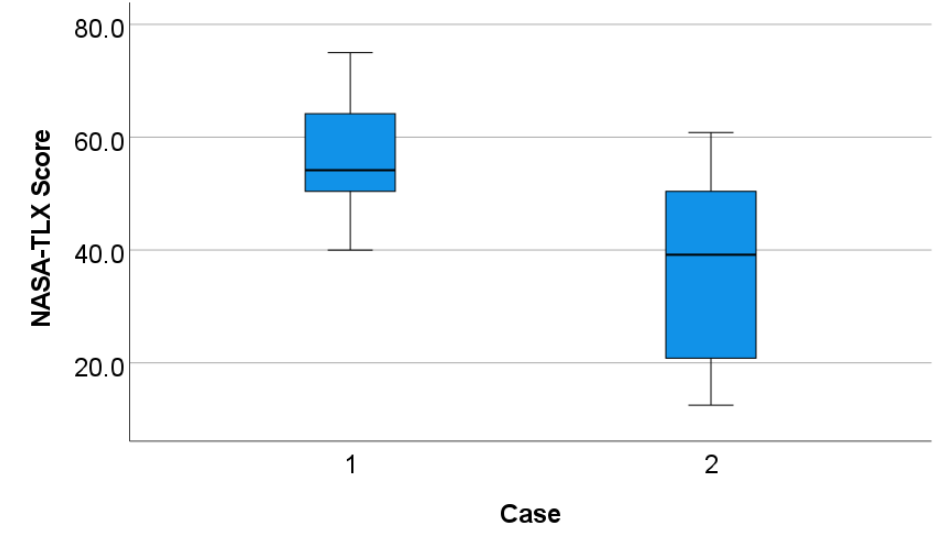
Figure 9. Averaged weight of the NASA-TLX ratings (Case 1: Position control and Case 2: Hybrid control).